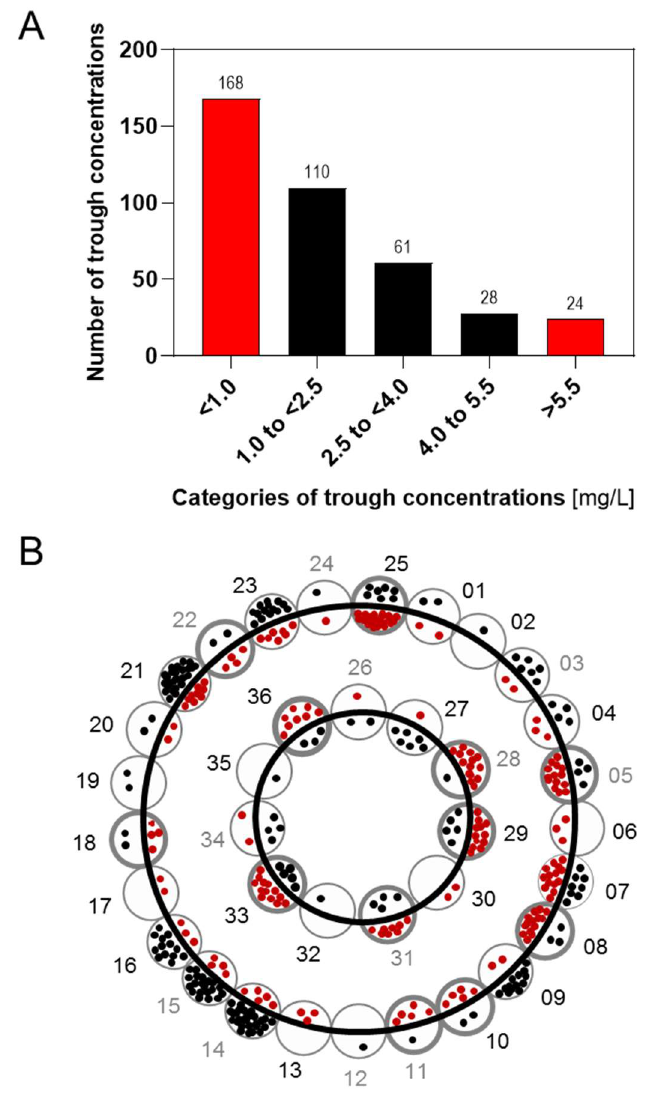
Figure 1. Descriptive analysis of C trough determined in children treated with voriconazole. ( A ) Results of therapeutic drug monitoring of voriconazole. ( B ) All voriconazole C trough obtained in one individ- ual were rated for the data point being within the range of 1–5.5 mg/L (black dots, within range; red dots, outside range). Individuals without DNA available are labelled in grey. Individuals with >65% of the C trough out of range are highlighted by a broader circle line width.